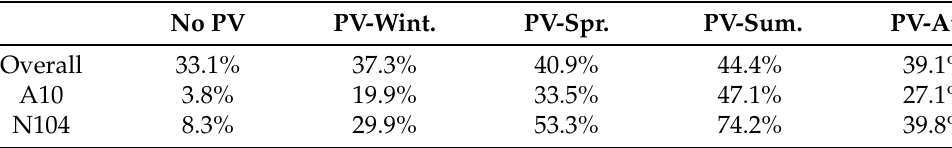
Table 8. Demand coverage with PV production per